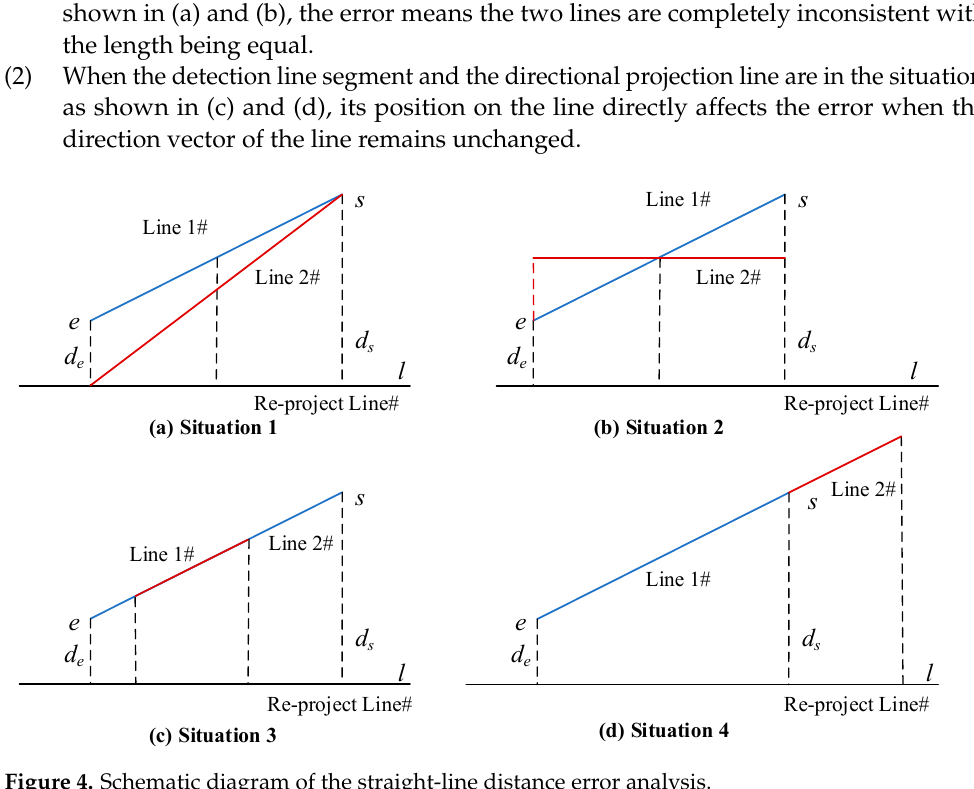
Figure 5. Schematic diagram of the linear distance representation in the different coordinate sys ‐ tems.